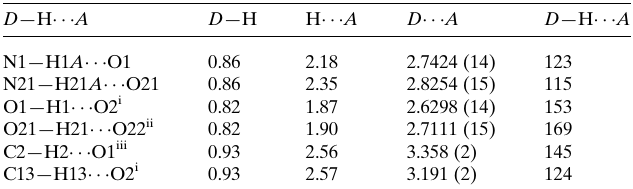
Table 1 Hydrogen-bond geometry (A˚ , (cid:2) ).